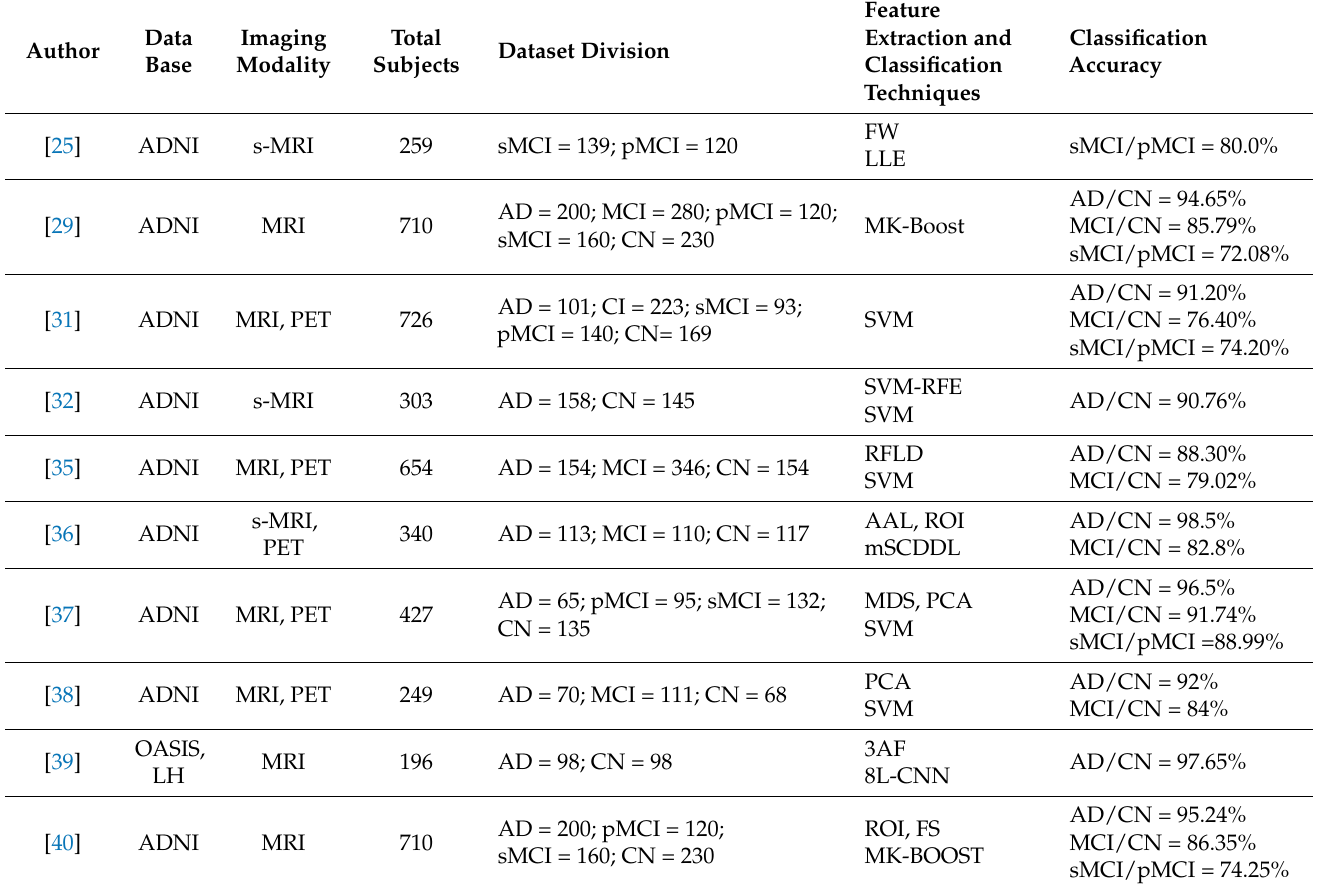
Table 1. A literature review. The acronym used is provided in the Appendix A of the